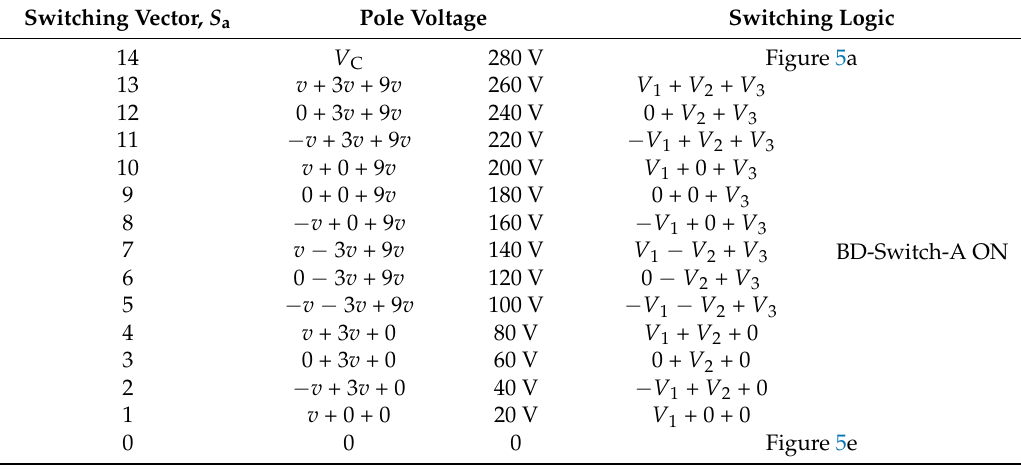
Table A4. Switching logic for generating 15 levels in the pole voltage.